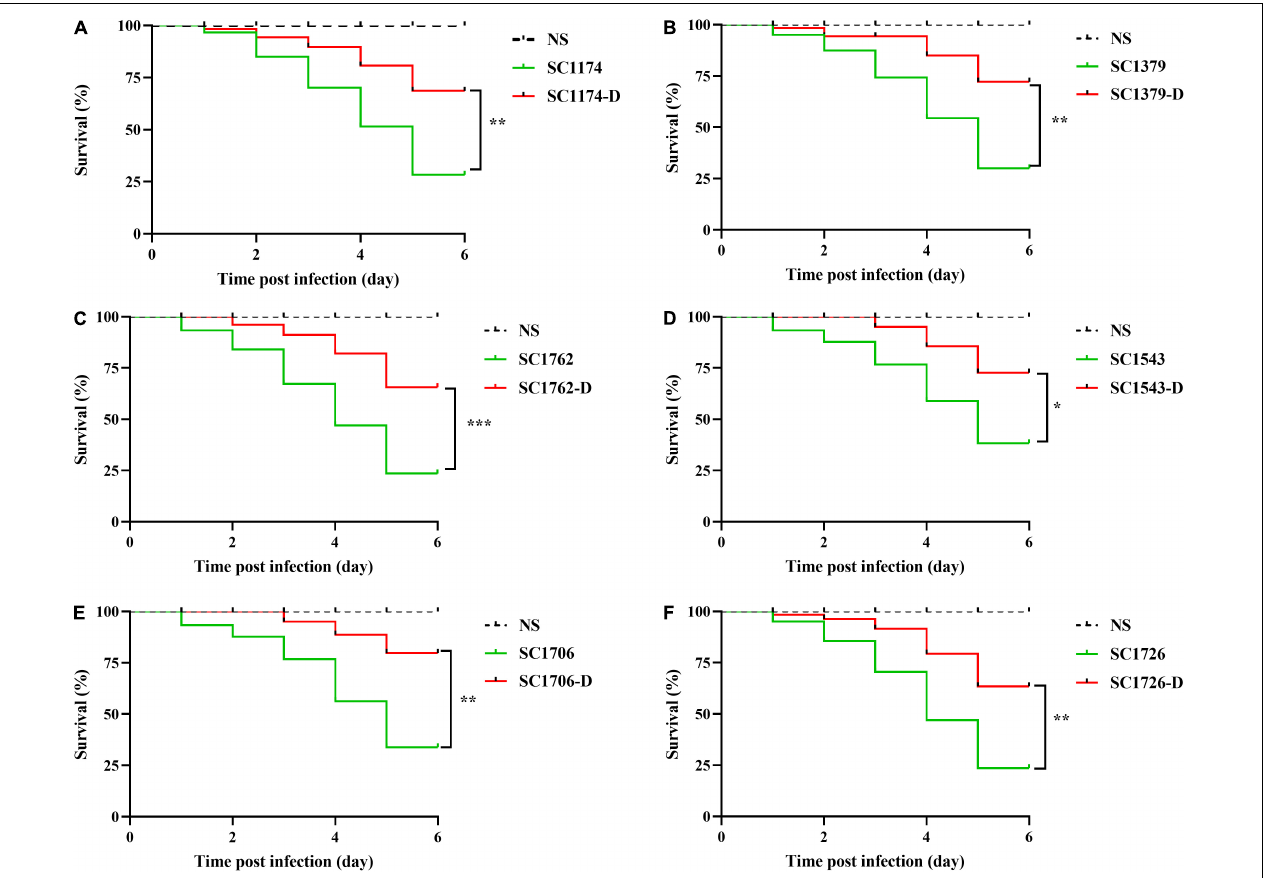
FIGURE 10 | Infection of Galleria mellonella larvae. (A–F) show the survival curves of Galleria mellonella larvae infected with SC1174, SC1379, SC1762, SC1543, SC1706, SC1726, and their corresponding evolved DAP-R mutants, respectively. Survival data are plotted using the Kaplan–Meier method and expressed as percentage of survival vs. time. The corresponding P -values are given in the parenthesis for each group using the log-rank test (* P < 0.05; ** P < 0.01; and ** *P <